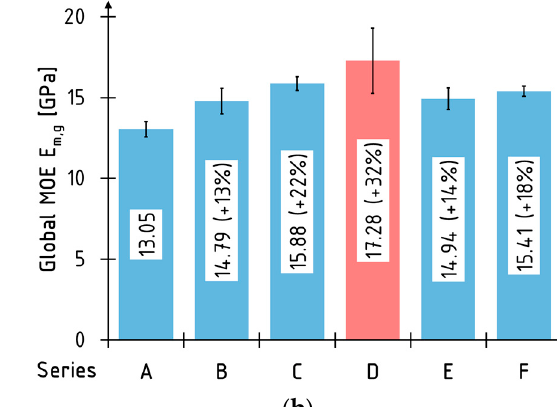
m,l ; ( b ) global E m,g